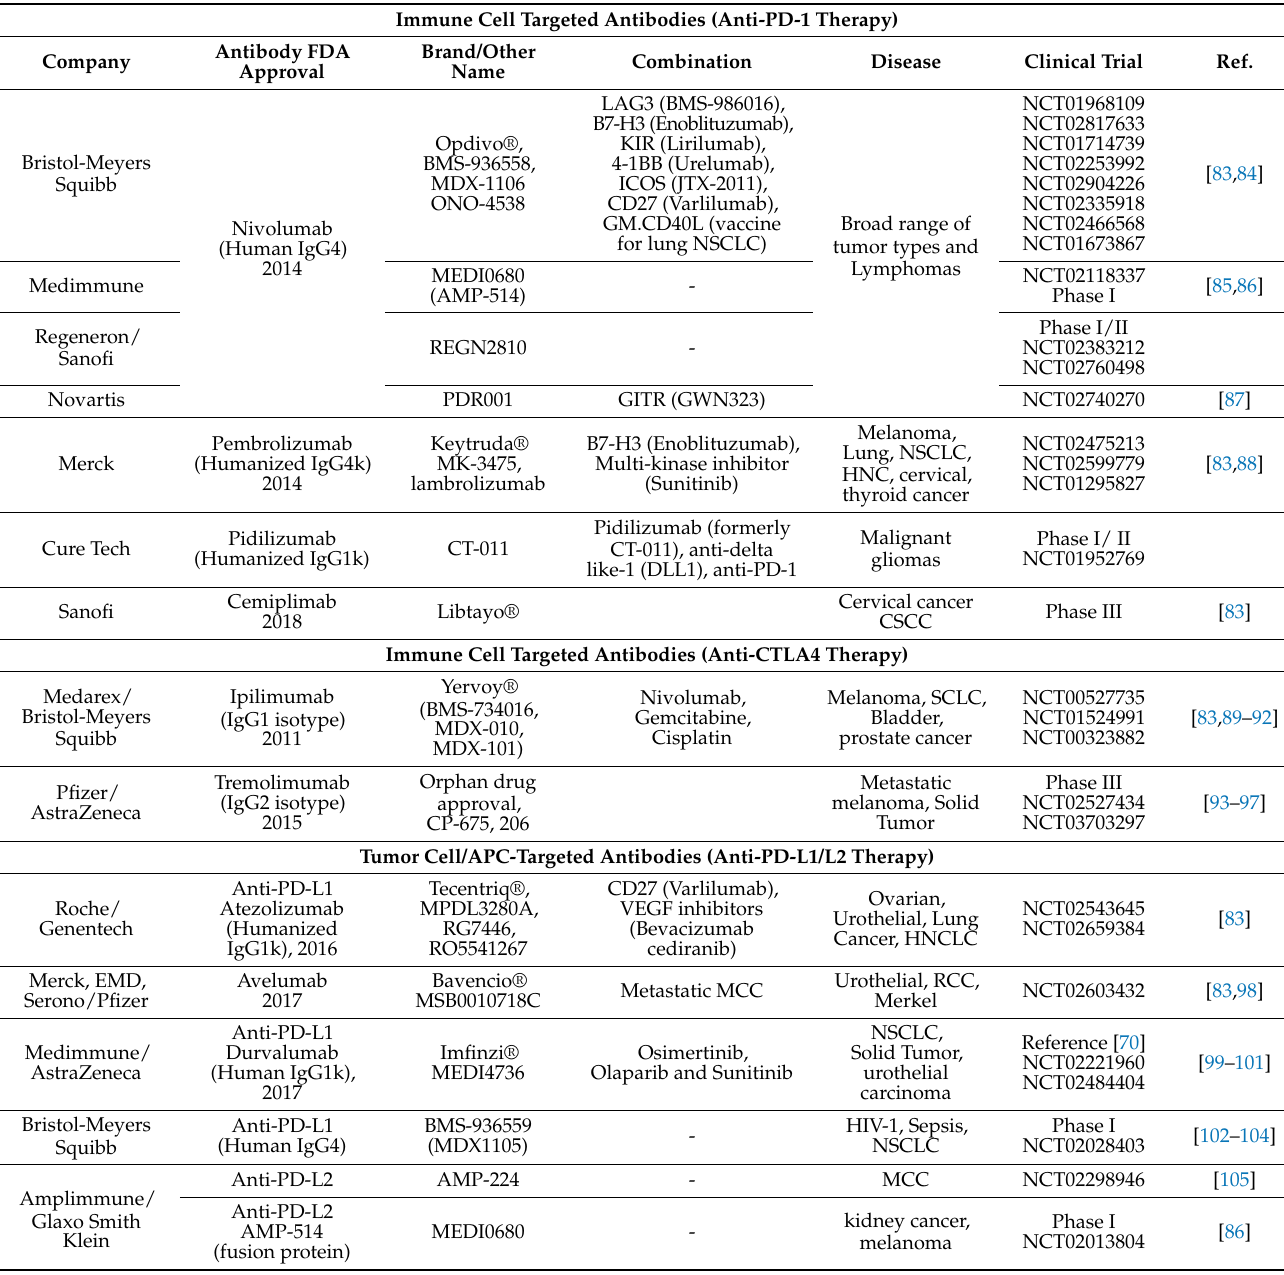
Table 2. Biopharmaceutical companies developing immune checkpoint blockade (ICB)-antibodies. Immune Cell Targeted Antibodies (Anti-PD-1